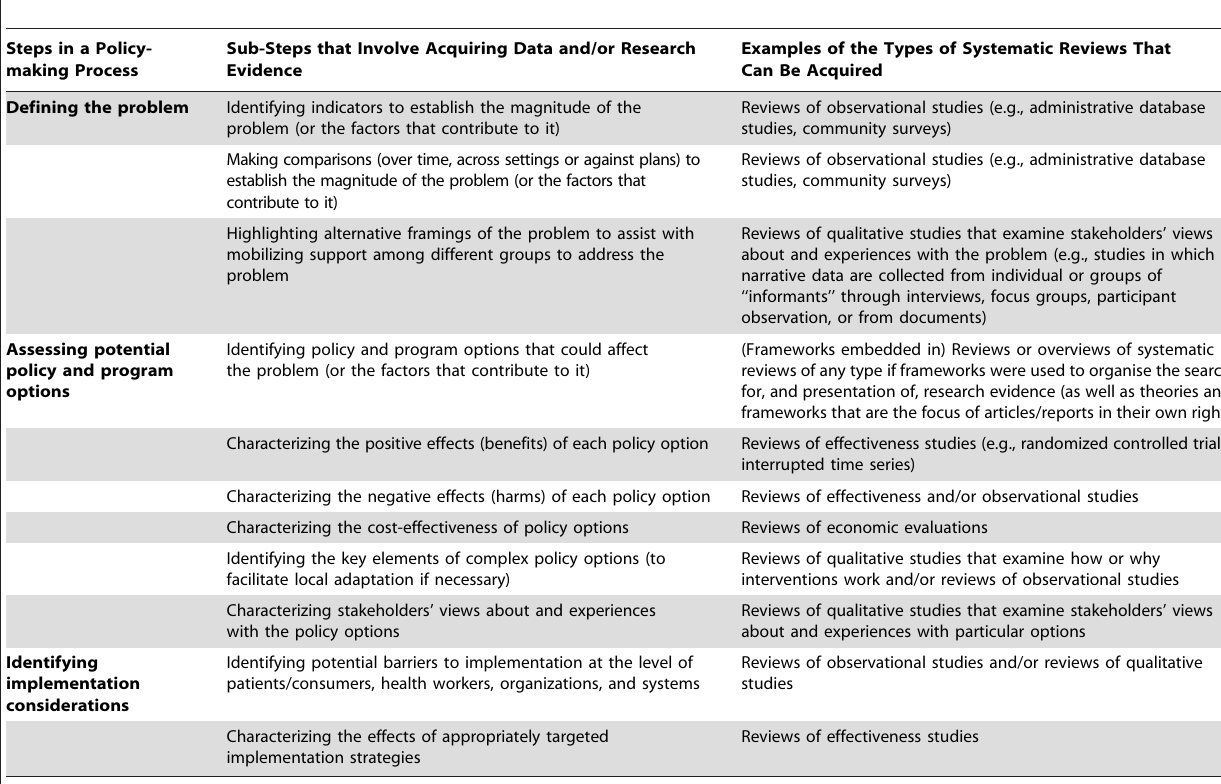
Table 1. Examples of the types of systematic reviews needed in different steps in the policymaking